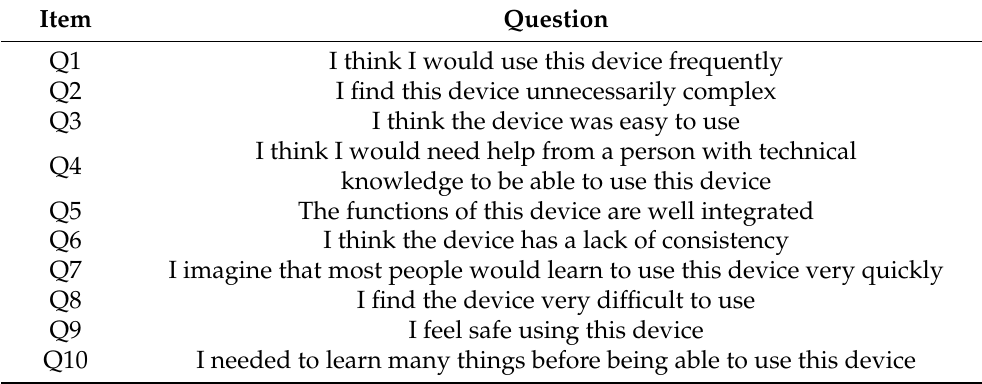
Table 2. System Usability Scale